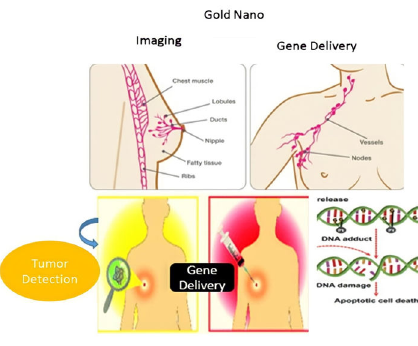
Figure 16. Schematic Gene Delivery of Gold Nanorods within DAN for MCF-7 breast cancer cell